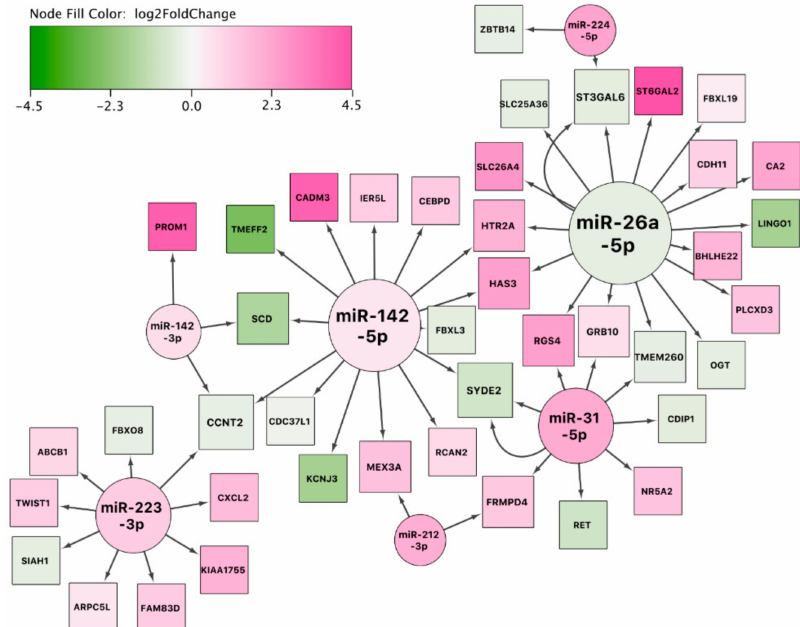
Figure 5. miRNA-gene interaction network using the set of di ff erentially expressed miRNAs and mRNAs between asthmatic horses in exacerbation and healthy controls. The color of the interior of the nodes represents the reported log2 fold change of the miRNA or gene, the node shape represents the feature type (miRNA: circle, target gene: square), and the node size represents the degree (number of in- and outgoing edges). Two arrows between two nodes indicate that the interaction is supported by both databases (e.g., between miR-31-5p and SYDE2).